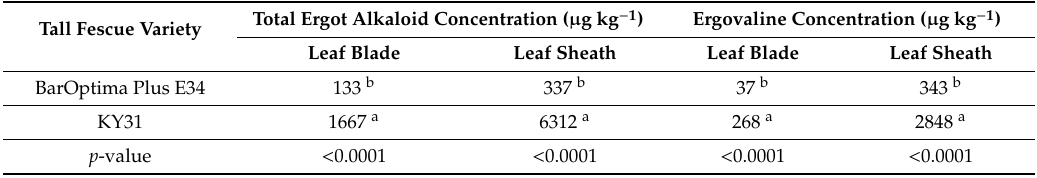
Table 8. Mean total ergot alkaloids and ergovaline concentrations ( µ g kg − 1 ) in the leaf blade and leaf sheath BarOptima Plus E34, and Kentucky 31 varieties of tall fescue sampled during 2012 and 2014 across Georgia and Kentucky. (Taken from [461]).